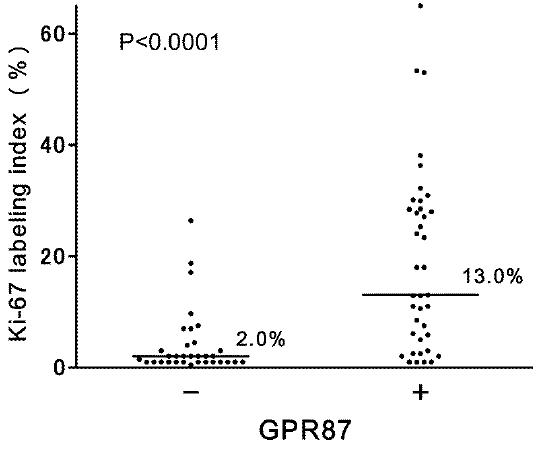
Figure 4. Relationship between GPR87 expression status and Ki-67 labeling index in non-muscle-invasive bladder cancers.